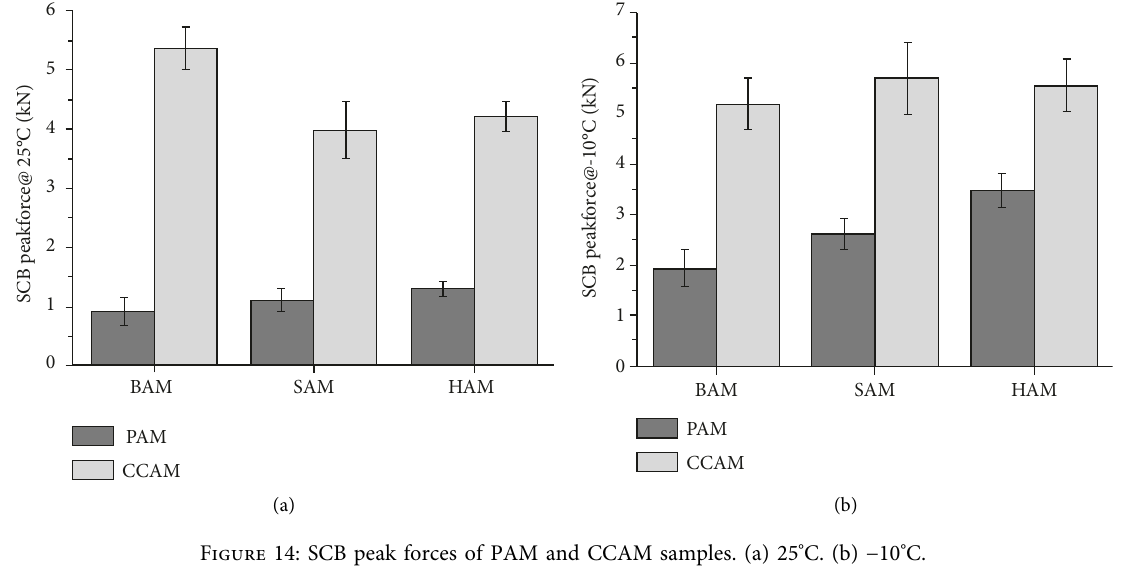
Figure 14: SCB peak forces of PAM and CCAM samples. (a) 25 ° C. (b) − 10 °